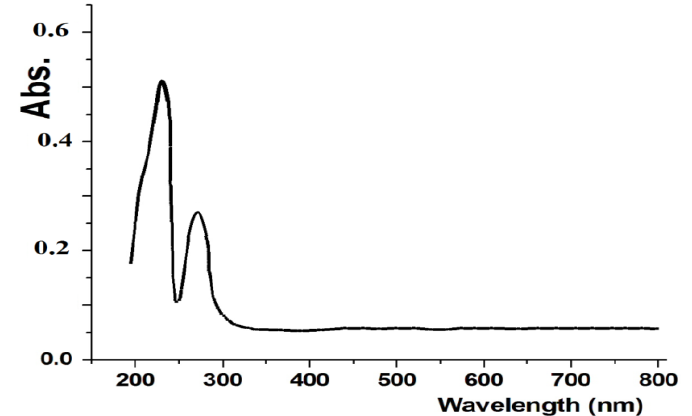
Figure 3. UV–Vis spectrum of 1 × 10 −5 M in CH 2 Cl 2 at